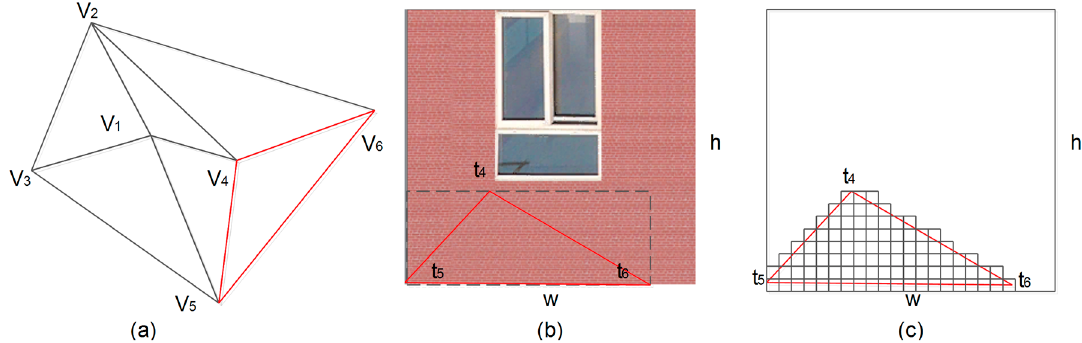
Figure 5. Texture mapping: ( a ) original triangle; ( b ) texture image; ( c ) pixel in the triangles.